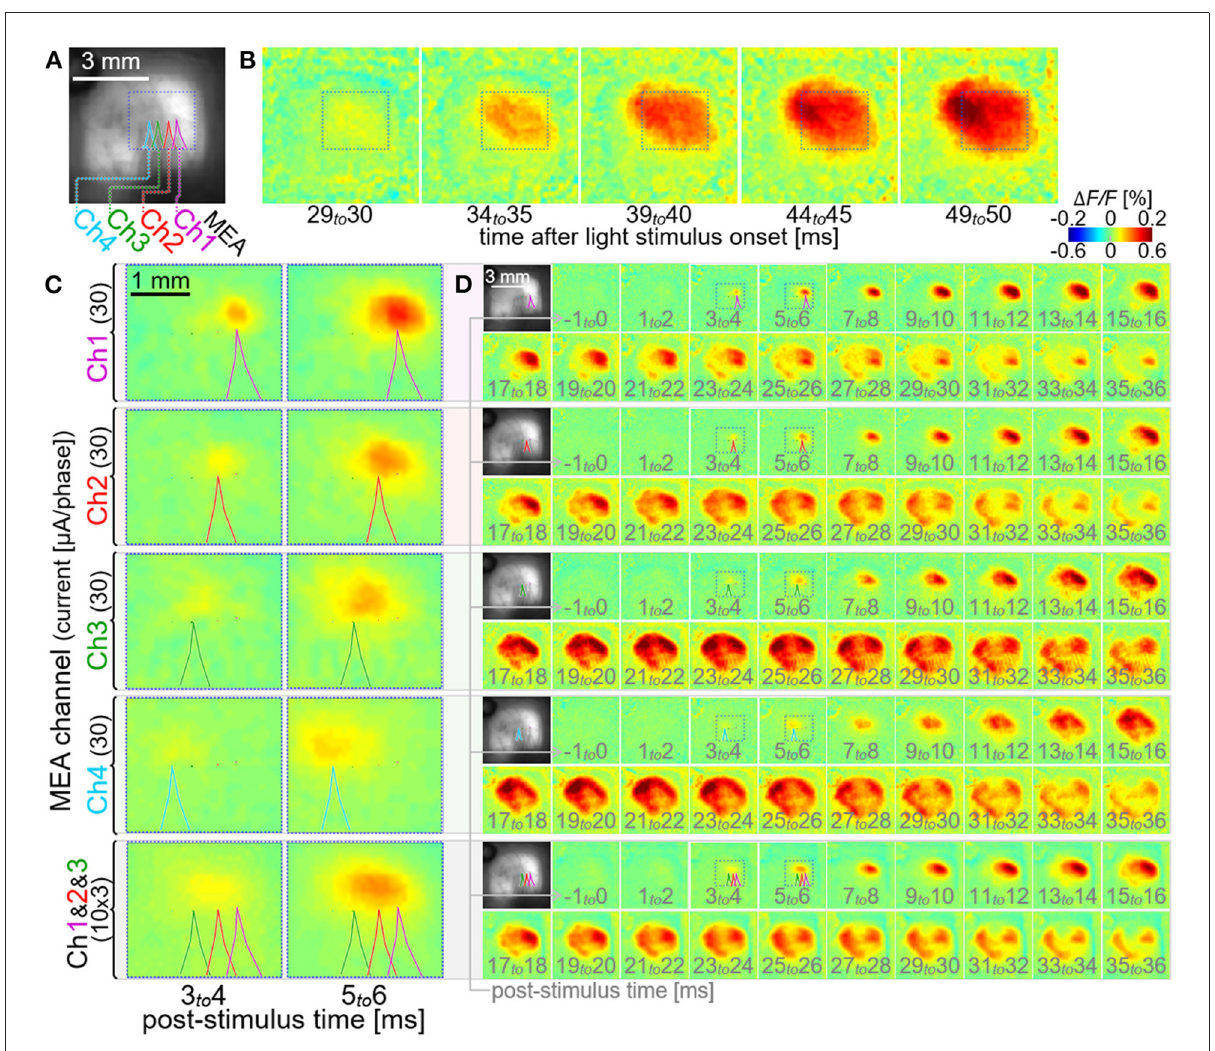
FIGURE7 Multi-site neural excitations with using the stimulation module. (A) VSD fluorescence image of the cortex. Colored lines indicate the outlines of shadows of four stimulating electrode shafts, Ch1, Ch2, Ch3, and Ch4. (B–D) Pseudo-color time-lapse 1 F/F images induced by the light stimulus (B) or the current stimuli delivered individually via either one of the four electrodes [upper four rows in (C,D) ] and simultaneously via three electrodes [bottom row in (C,D) ]. The images in C show expanded views of the VSD images in the dotted boxes in (D) . All the dotted boxes in (A–D) represent the same region on the cortex in the